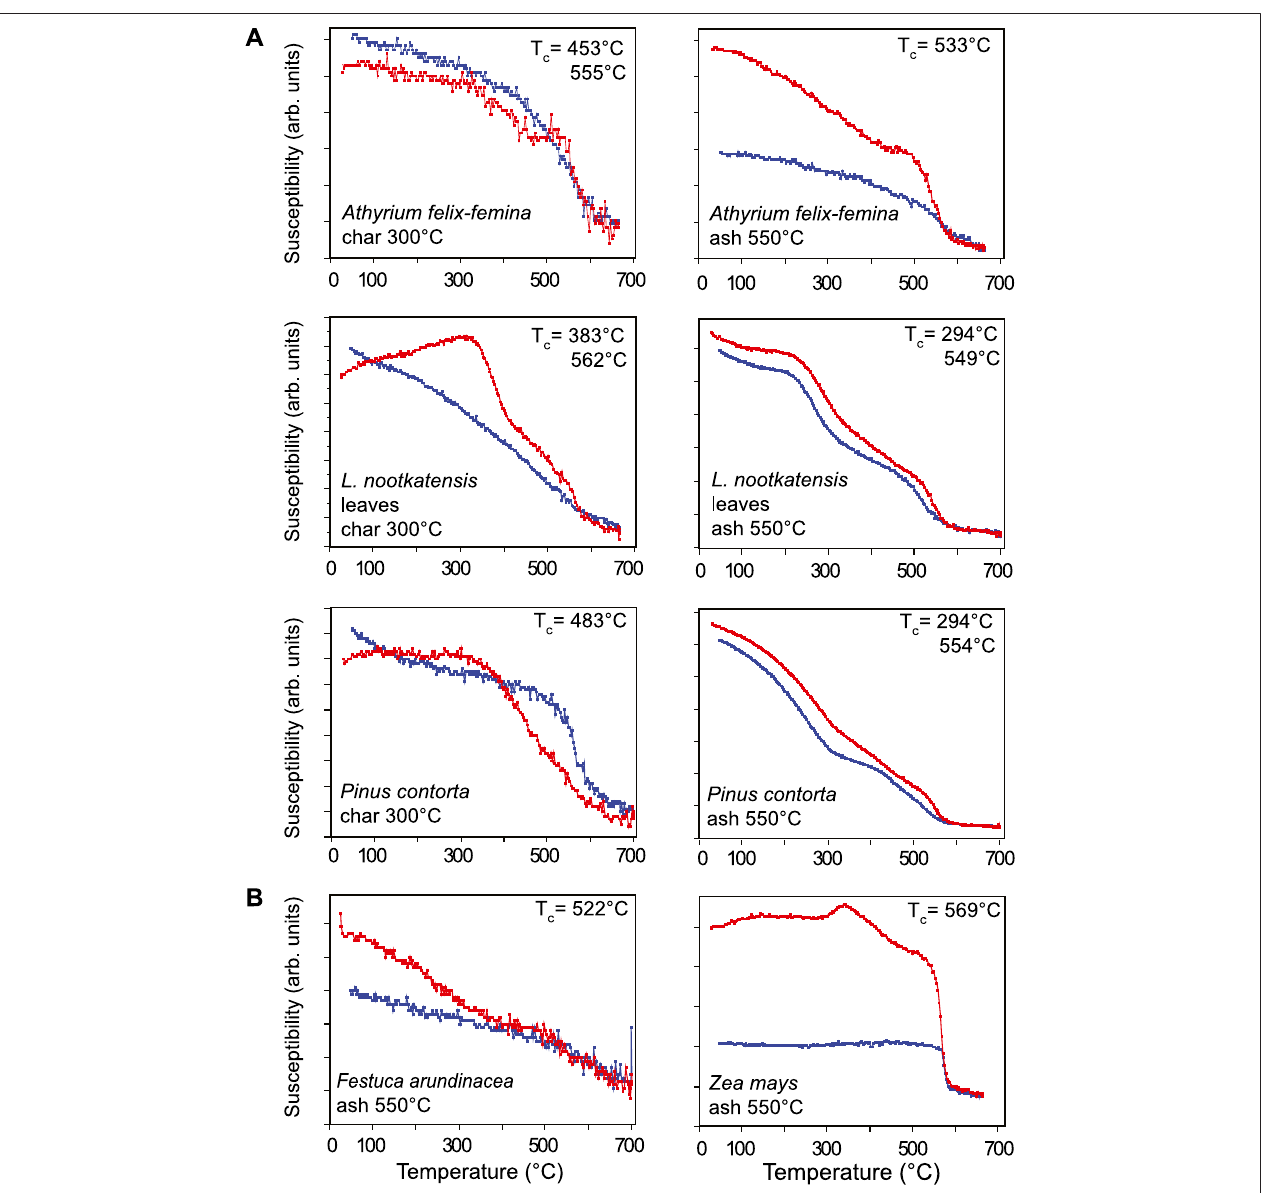
FIGURE1| Example thermomagnetic curves ofsusceptibilitymeasured onwarming (red) and cooling (blue) forselectedash and charfrom (A) Icelandicplant litter and (B) German plant samples.